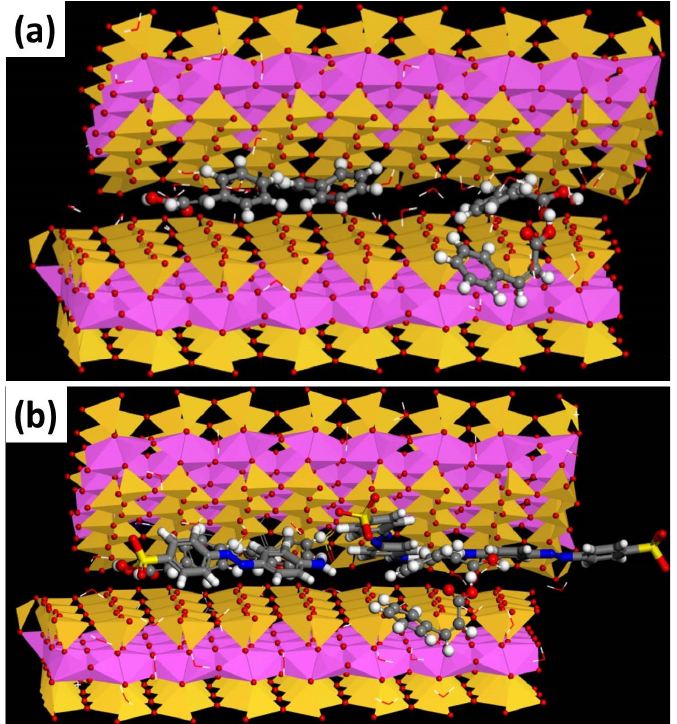
Figure 4. Schematic representation of CA modified bentonite ( a ) and MO adsorbed, CA modified bentonite ( b ), after equilibrium, a snapshot of the adsorption system (Note: C = grey, N = blue, H = white, O = red, Si = yellow, Al = pink, Mg = green for all species).